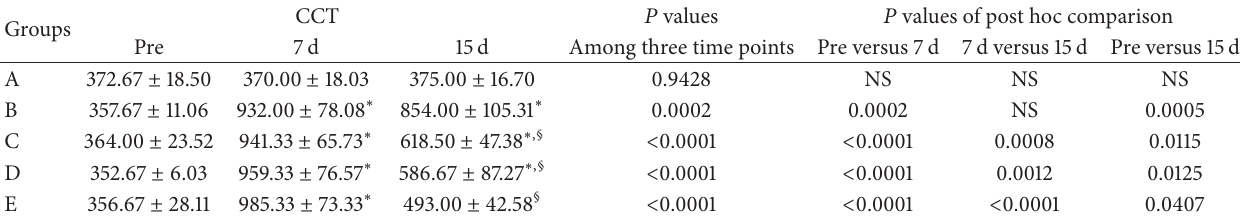
Table 3: Central corneal thickness (CCT) of each group at different time points pre- and postoperatively. Groups